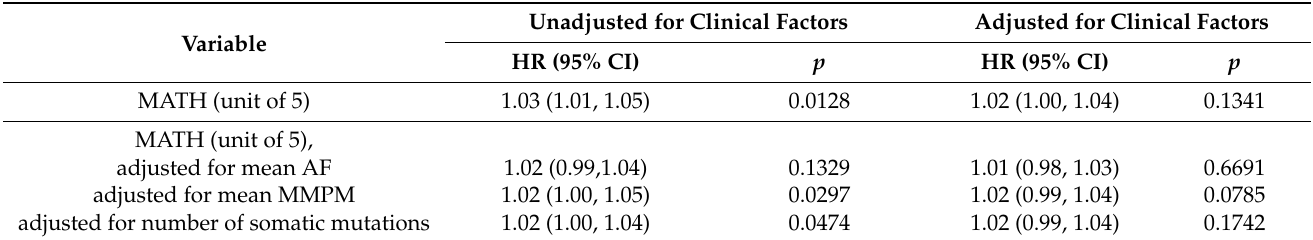
Table 3. Association of pre-induction MATH with